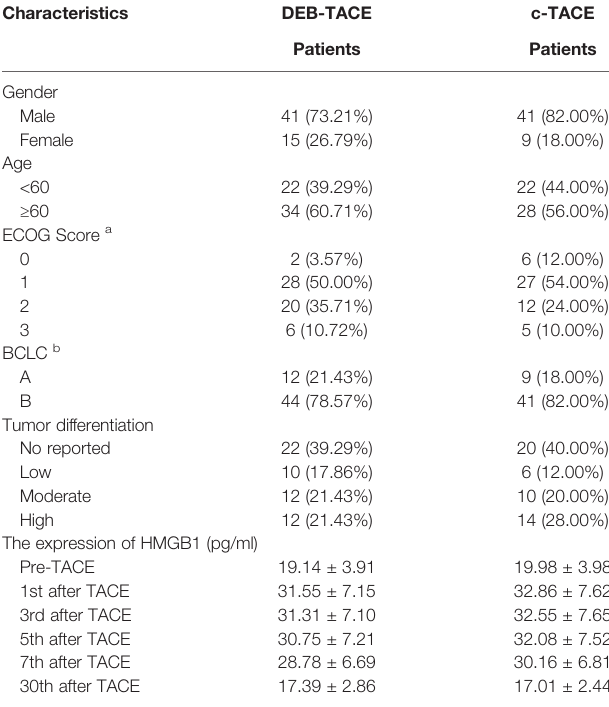
TABLE 1 | Patients ’ characteristics before